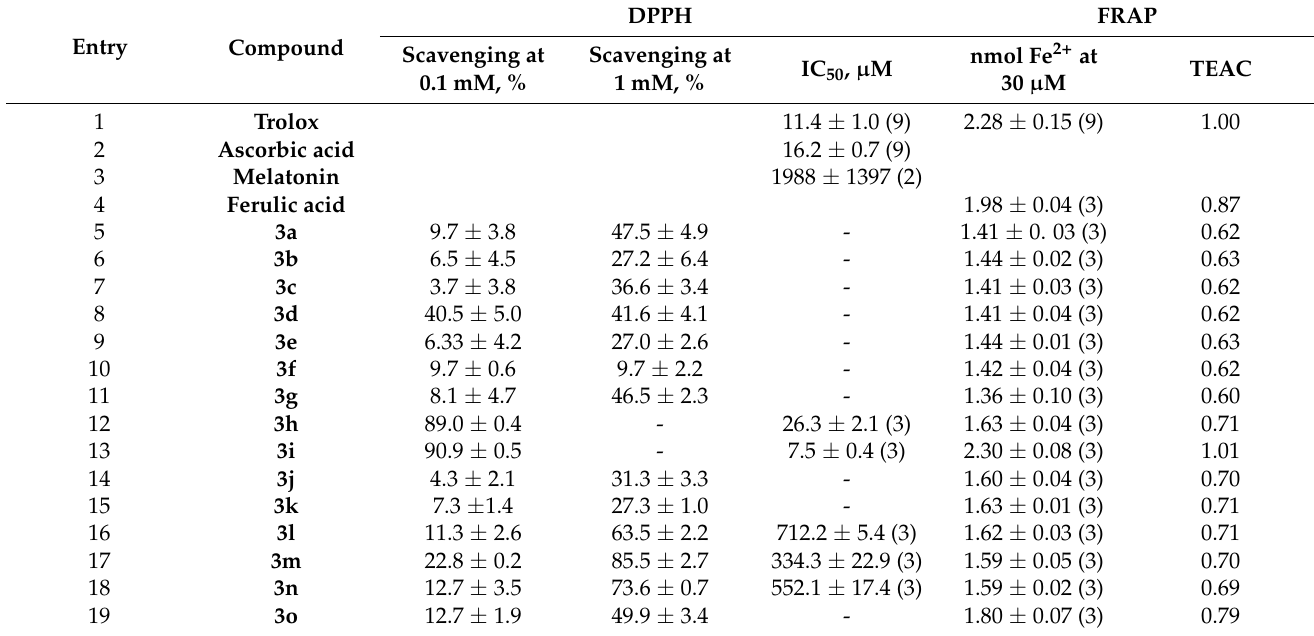
Table 2. Radical scavenging properties of compounds 3 in the DPPH and FRAP assays.